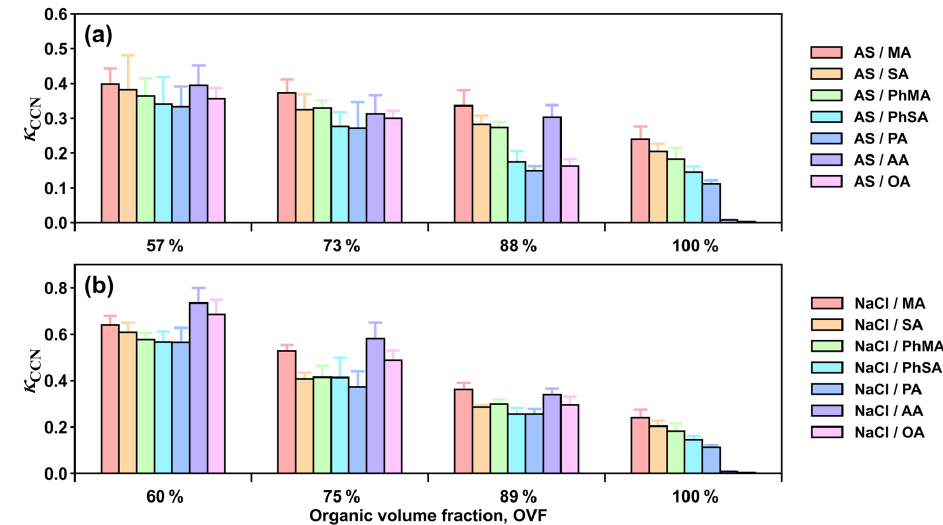
Figure 3. κ CCN of (a) AS–dicarboxylic acid and (b) NaCl–dicarboxylic acid mixed particles with varied OVF.